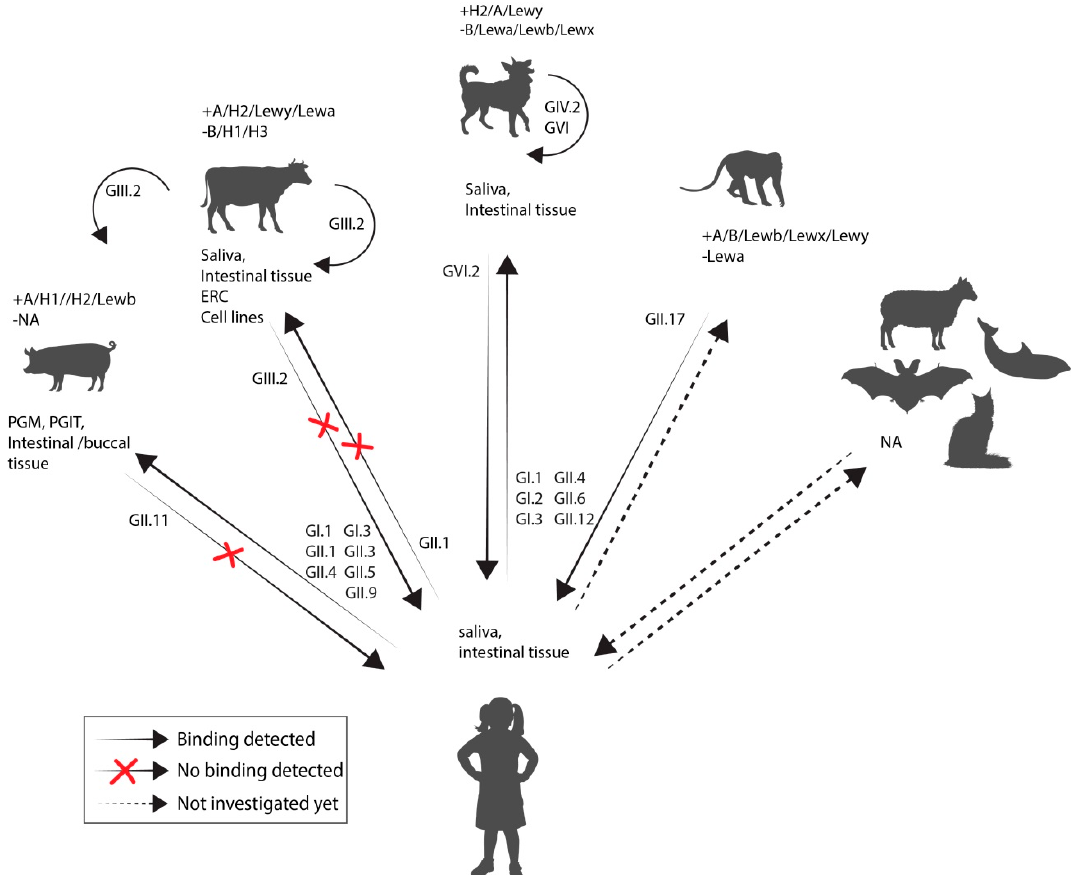
Figure 4. Results of binding studies with animal and human norovirus VLPs. The histo-blood group antigen (HBGA) phenotype is indicated with the presence ( + ) or absence ( − ) for di ff erent glycans. Arrows indicate direction in which attachment was tested and whether attachment was observed or not (red cross). Dotted arrows indicate that attachment has not been assessed yet. The half circular arrows indicate binding of animal norovirus to tissue / saliva of either the same or another animal